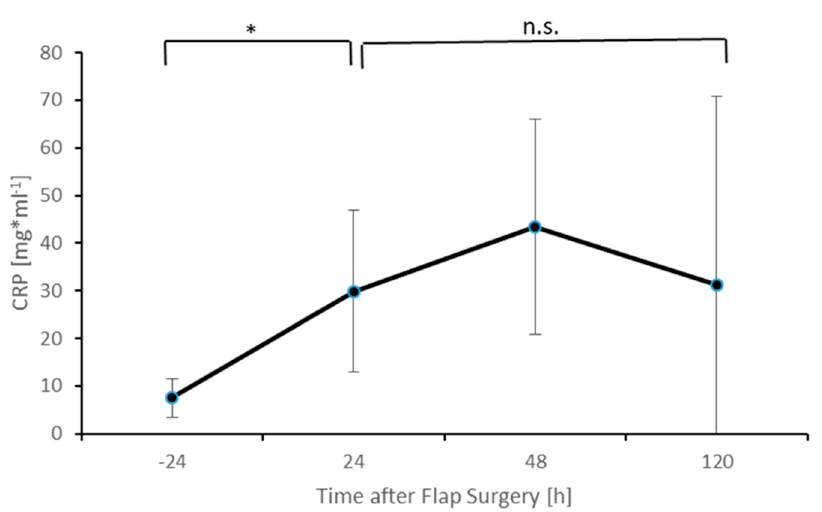
Figure 3. Postoperative CRP levels. Columns indicate mean values; error bars refer to the corre- sponding standard deviations (* p ≤ 0.05; n.s. = not significant).